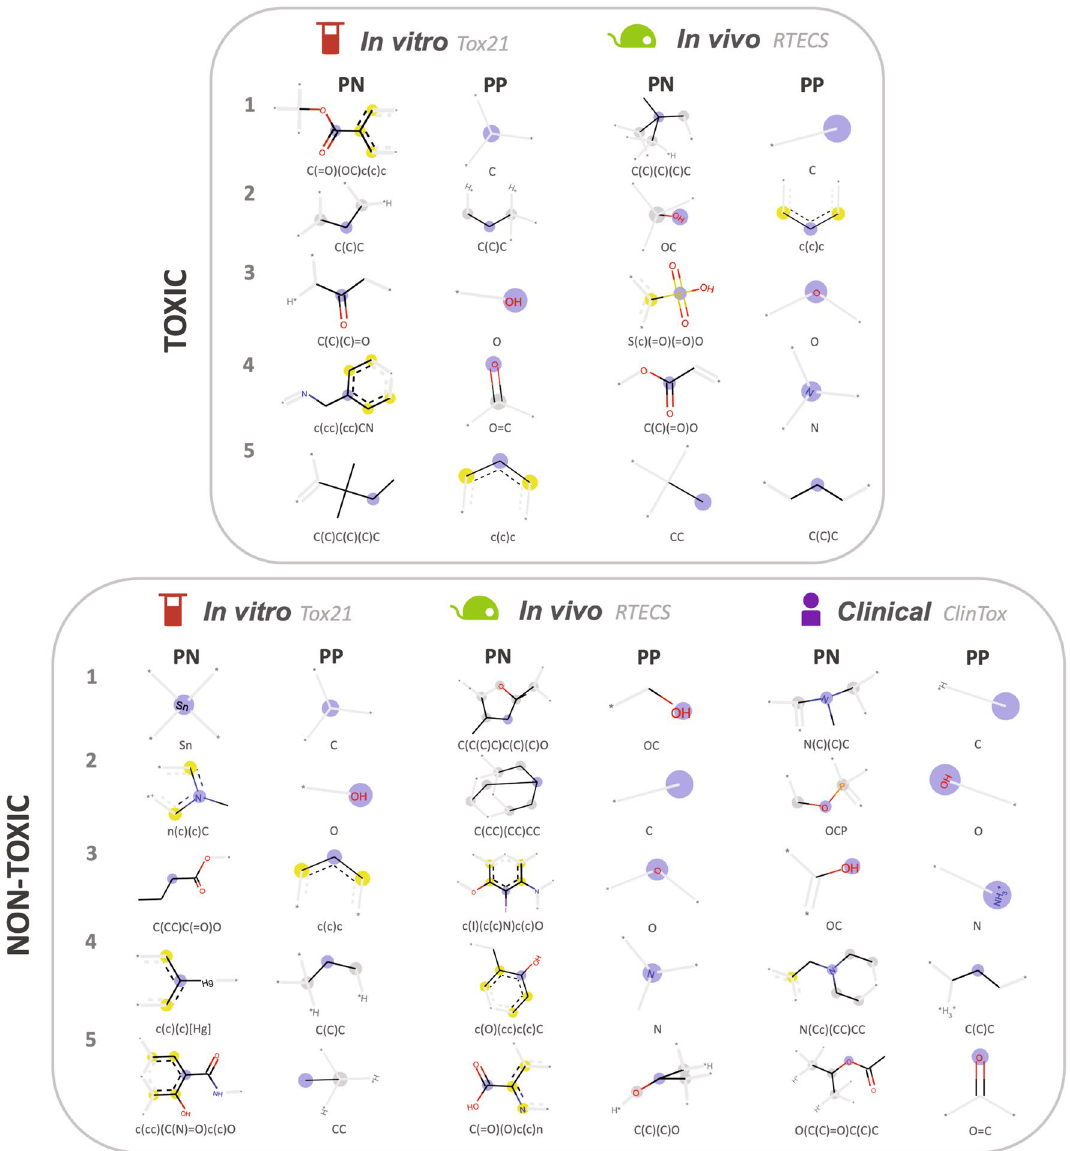
Figure 6. Most common PP and PN substructures of correctly predicted toxic and nontoxic molecules across the Tox21, RTECS, and ClinTox endpoints. ClinTox only had 1–2 examples of toxic molecules in the test set and thus was excluded here. All top 10 in Supplementary Figs. S7 and